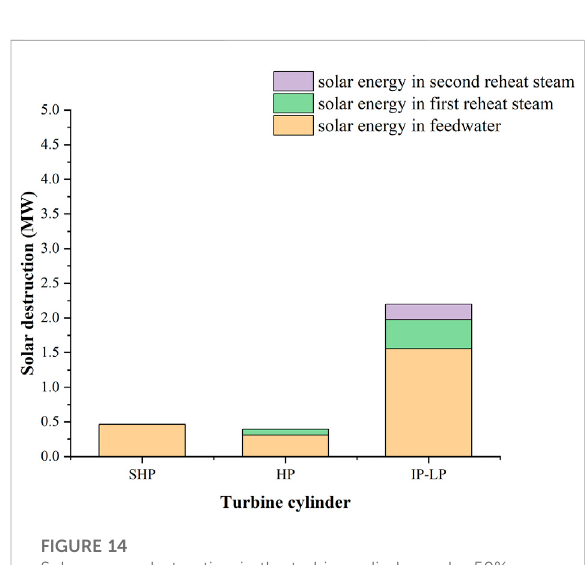
FIGURE 14 Solar exergy destruction in the turbine cylinder under 50% THA